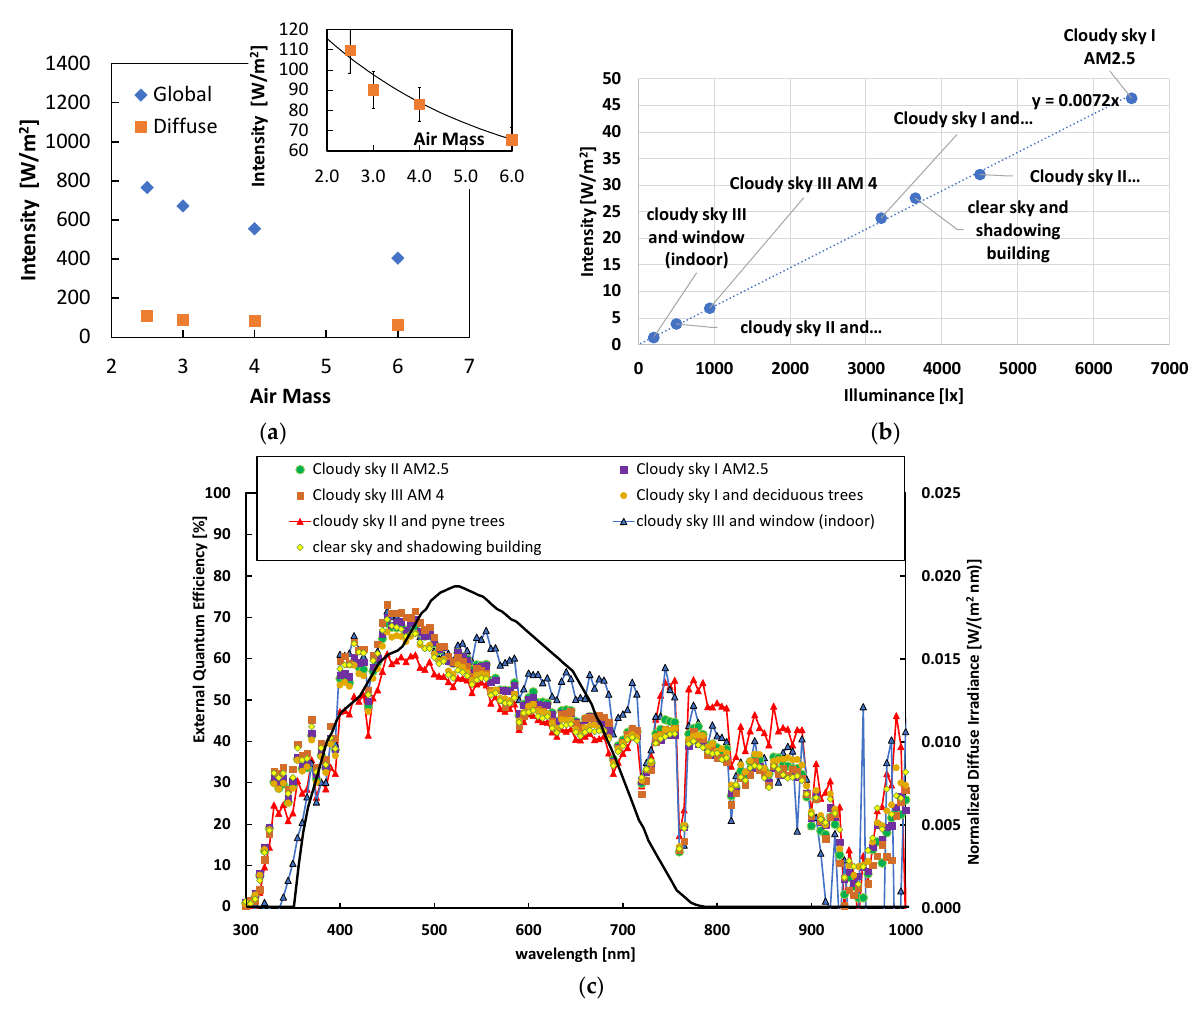
Figure 4. ( a ) Intensity calculated from SMARTS toolkit as the integral of the irradiance in the 300–1000 nm range in the case of the global and diffuse spectra given in Figure 3c. ( b ) Intensity given as the integral of spectral irradiance in the 300–1000 nm range, measured in various outdoor and indoor diffuse radiation conditions: cloudy sky, shadowing of trees and buildings and shielding of transparent glass windows. The intensity is plotted as a function of the corresponding measured illuminance in lx. The linear best fit is also shown. ( c ) Measured diffuse spectra in the conditions from ( b ), normalized to the case of 1000 lx (right axis). The external quantum efficiency of the DSSC modules is added for comparison (left axis, solid line).